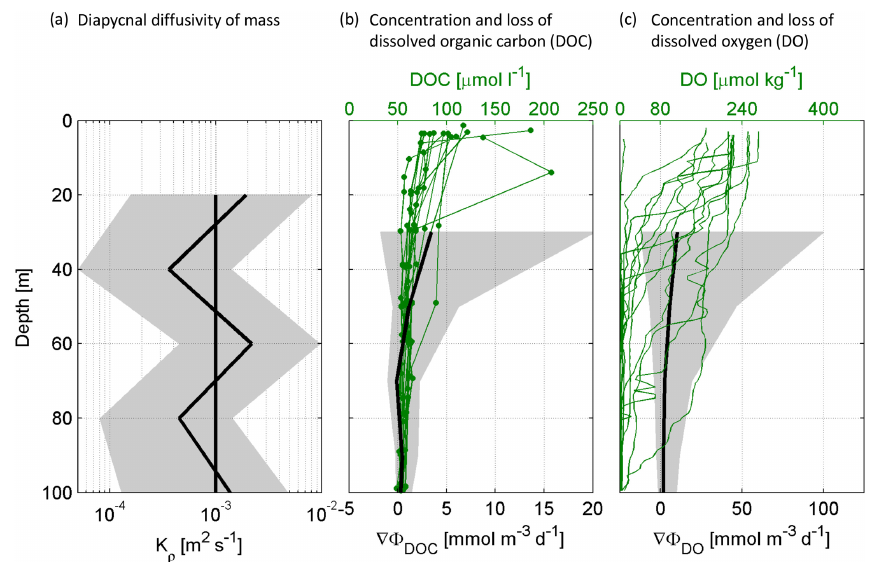
Figure 2. Measured concentrations and calculated proxies for the change in dissolved organic carbon (DOC) and dissolved oxygen (DO) flux over depth for stations G–T: The average diapycnal diffusivity of mass ( K ρ ) over depth with confidence interval and the constant K ρ (1 × 10 − 3 m 2 s − 1 ) that was used for further calculations (a) . Concentrations of DOC in the upper 100m and the resulting change in DOC flux over depth ( ∇ (cid:56) ) (b) . Concentrations of DO in the upper 100m and the resulting change in DO flux over depth ( ∇ (cid:56) ) (c)